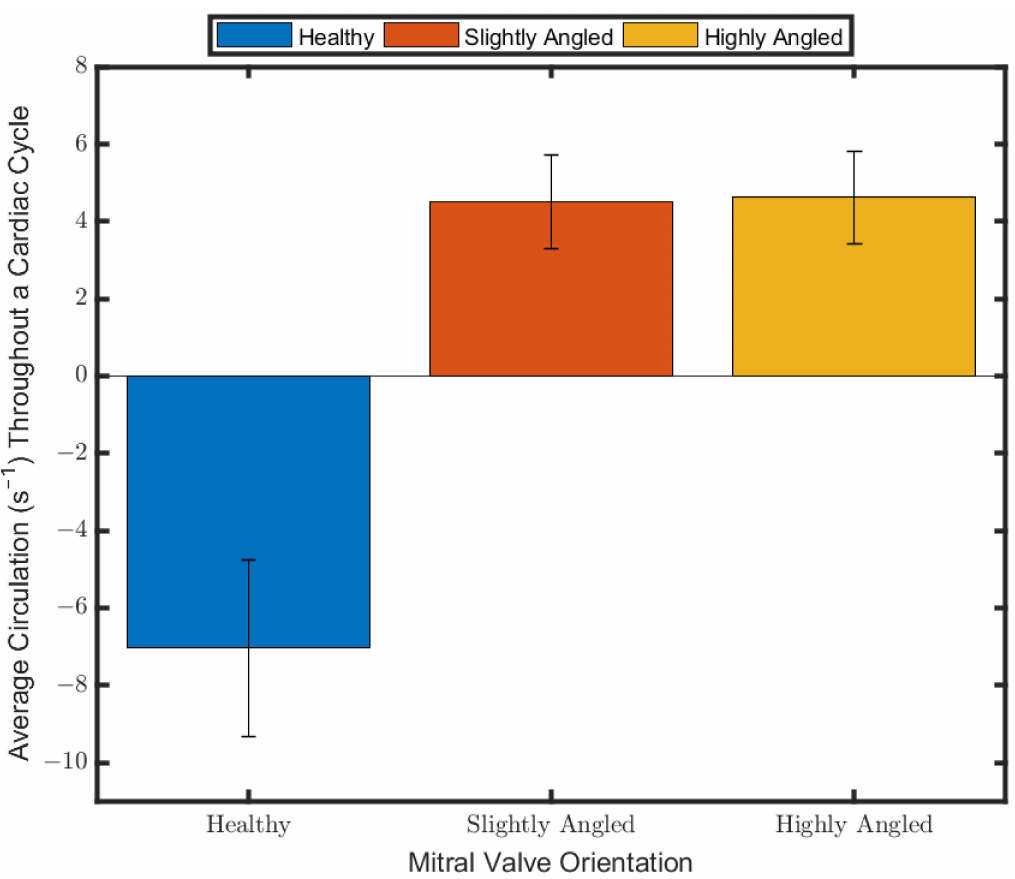
Figure 7. Temporal average circulation per unit area of the flow over the entire cardiac cycle. The p -values between the healthy case and slightly angled case, between the healthy case and highly angled case, and between the slightly angled and highly angled case are p < 0.01, p < 0.01, and p = 0.12, respectively. Note that the absolute value of the circulation was